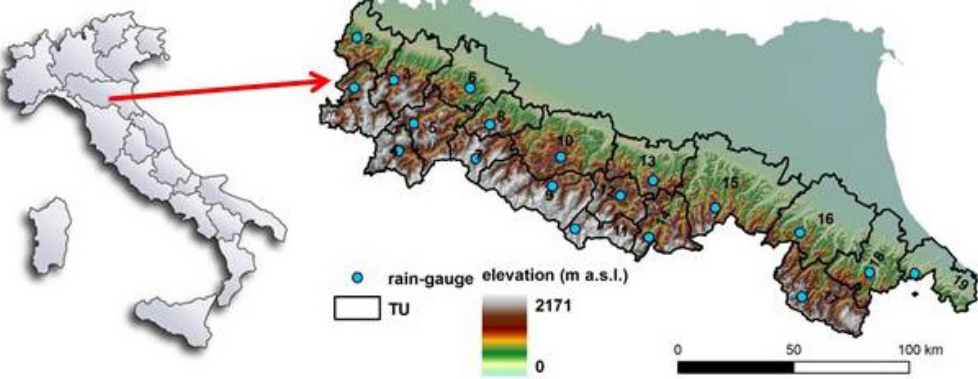
Fig. 1. The Emilia Romagna region. The study area is partitioned into 19 territorial units (TU), each provided with a reference rain gauge.